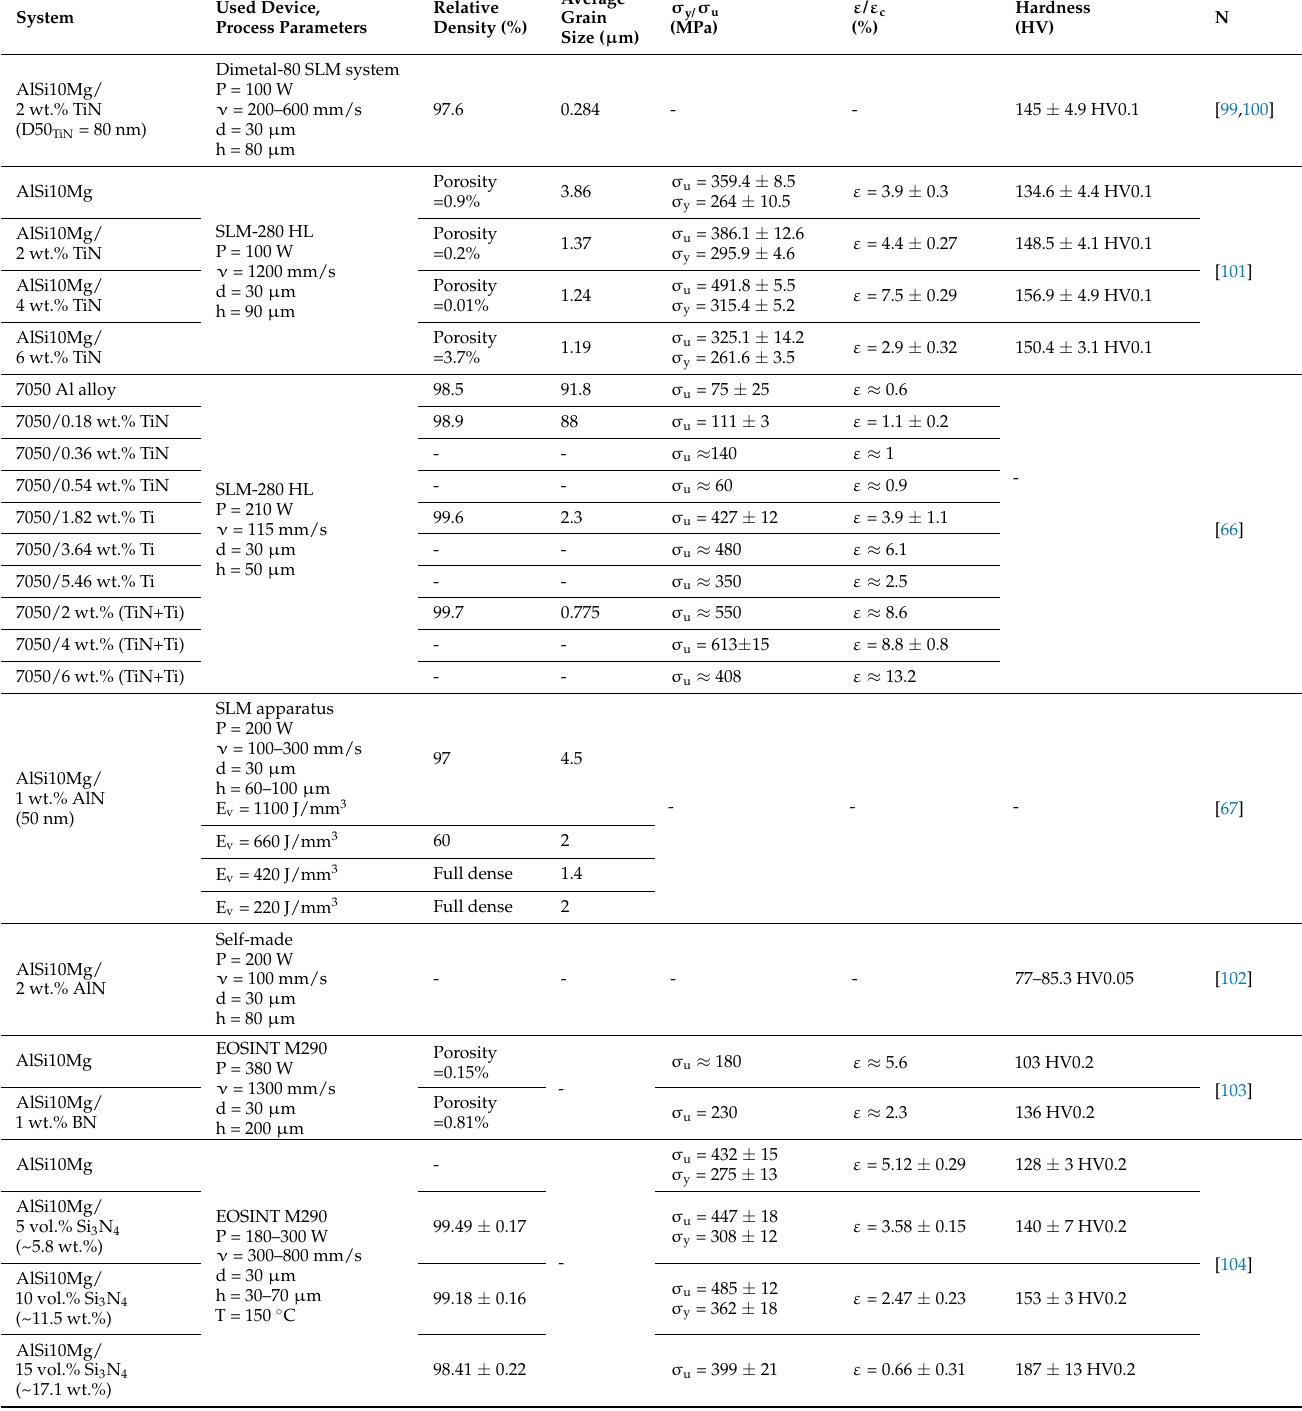
Table 3. Characteristics of nitride reinforced AMCs fabricated by laser powder-bed